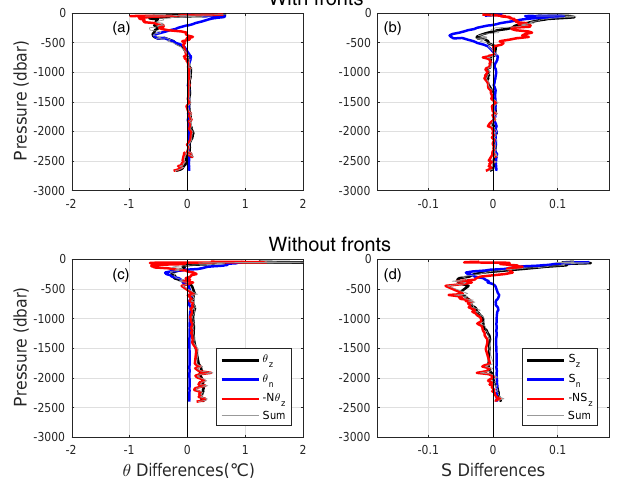
Figure 6. Comparison between the isobaric changes from 1999 to 2010 carried out with the whole dataset of each year ( a , b , same as Fig. 5) and without the stations where the fronts are located (c, d) . Isobaric changes from 1999 to 2010 ( θ z , black line) decomposed into changes along neutral surfaces ( θ n , S n , blue line) and changes due to the vertical displacement of isoneutrals ( − N θ z , − NS z , red line) for temperature (a, c) and salinity (b, d) . The grey line shows the sum of both components.